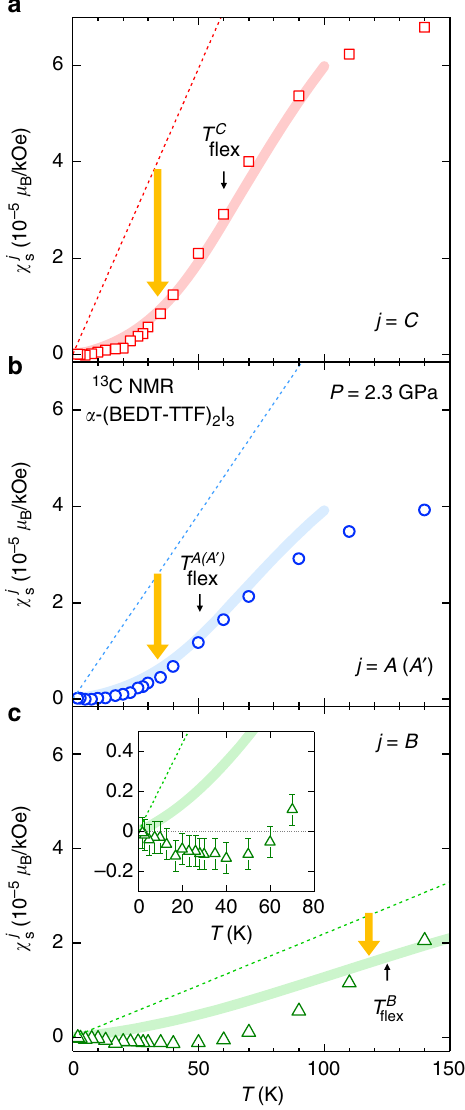
Figure 3 | Temperature driven velocity renormalization. ( a – c ) Temperature dependence of the calculated spin susceptibility in the RG approach (bold curves) for the non-equivalent site j ¼ C ( a ), A ( ¼ A ’) ( b ) and B ( c ) in the unit cell, plotted together with the experimental w j T ð Þ s (symbols). Thin arrows indicate the inflection point, T j . As the flex non-interacting reference in the RG theory, we assumed the effective TB model of ref. 25. The susceptibilities are calculated as discussed in the text by employing the momentum cutoff L ¼ 0.667Å (cid:2) 1 and the optimum parameters ( u , e ) ¼ (0.35, 1), determined from the fit to the data p T ) indicates the expected T dependence (Methods). The dotted lines ( w j s for gapless excitations around the DP in the absence of the RG correction 68 , where the bandwidth reduction effect is incorporated (through the T ð Þ with parameter u ). Thick bold arrows represent the suppression of w j s p T due to the RG flow of the velocities, where the velocities respect to w j s flow towards larger ln L = q j jð Þ (longer wavelengths) on decreasing T . That is, T plays the role of the flow parameter in the experiment, and the RG flow around E F . The manifests itself typically in the energy range of D E j (cid:3) k B T j flex . Error bars stand for the insets of c : the low- T close-up of w B s